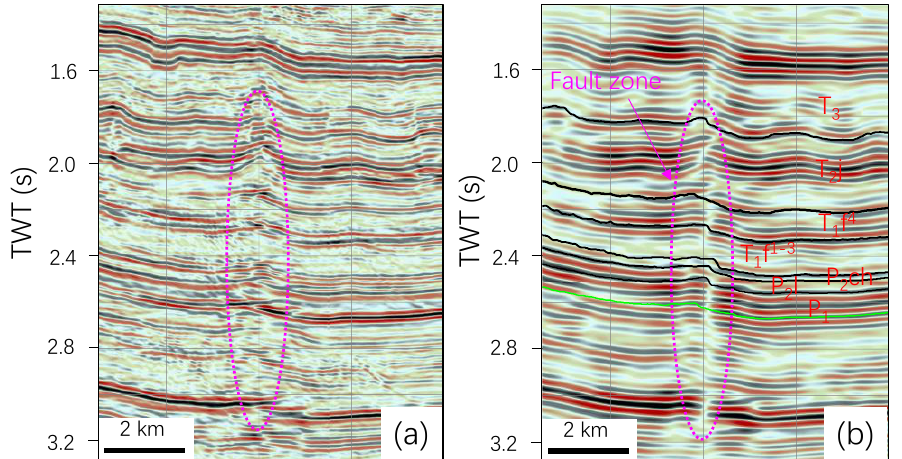
Figure 3. ( a ) A seismic section and ( b ) its processed section by steerable pyramid processing in this study area (the red arrows indicate strike-slip fault).